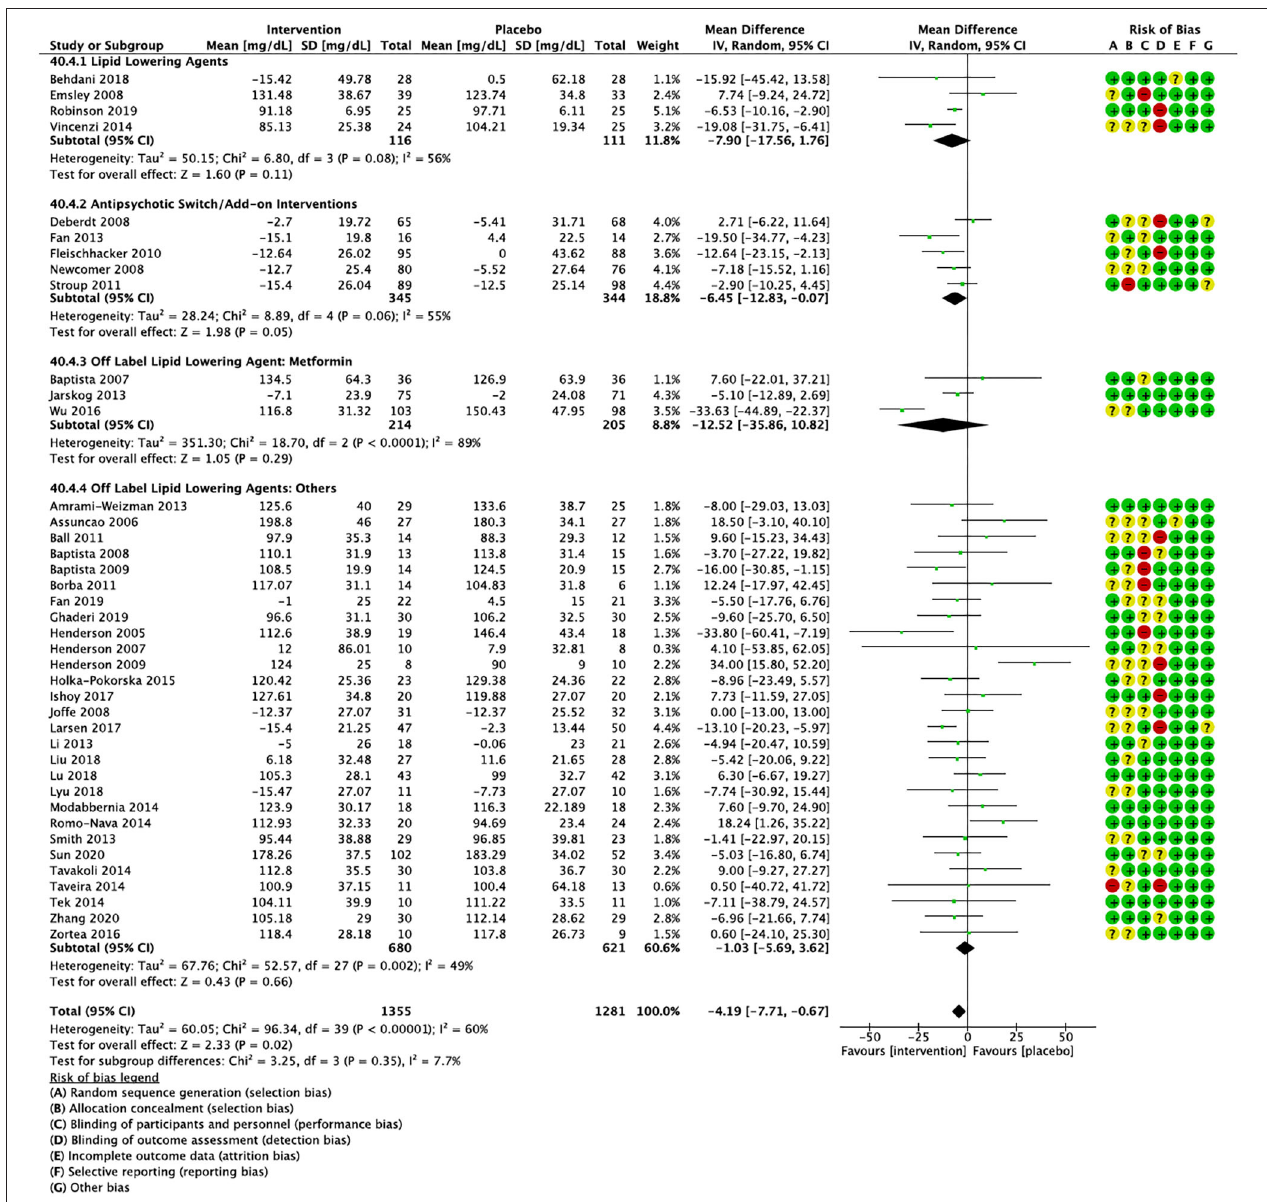
FIGURE 4 | Forest plot showing the pooled mean difference in changes in low-density lipoprotein cholesterol (mg/dL) for all interventions as compared to placebo along with subgroup analyses and Risk of Bias assessments.